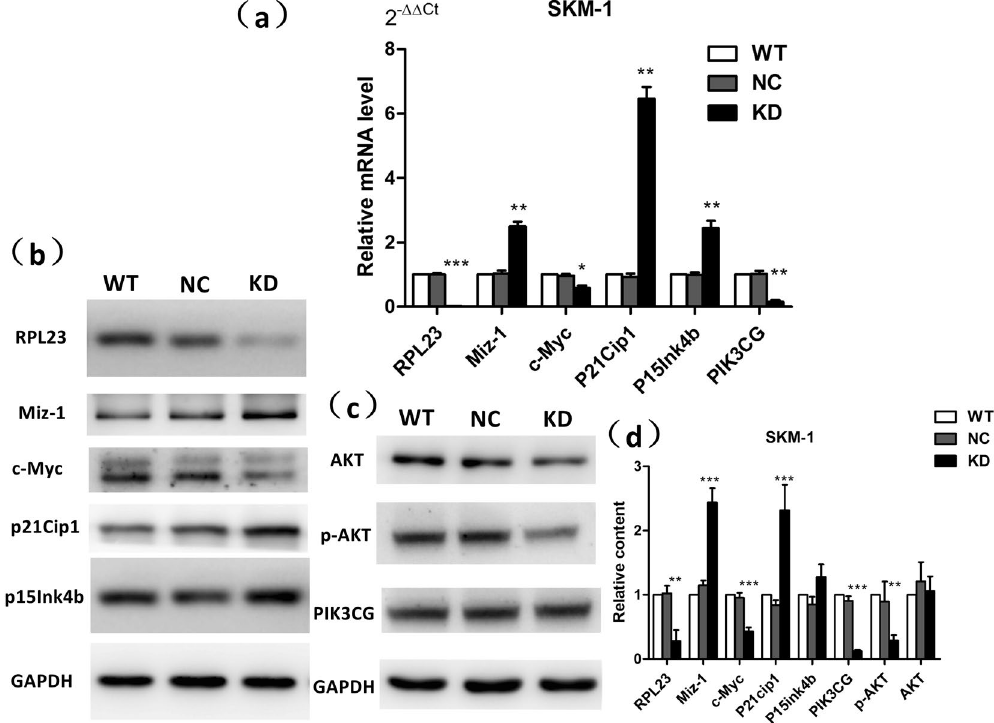
Figure 3. Validation of screened mRNAs identified by microarray analysis through qRT-PCR and western blotting of SKM-1 cells. ( a ) The mRNA expression levels of RPL23-KD-associated genes were analysed by qRT- PCR. The Miz-1 (2.50 ± 0.14, p = 0.009), p15 Ink4b (2.44 ± 0.23, p = 0.003), and p21 Cip1 (6.46 ± 0.37, p = 0.005) expression levels were increased in the KD group compared with the NC group, whereas the RPL23 (0.02 ± 0.01, p < 0.001), c-Myc (0.58 ± 0.08, p = 0.031) and PI3KCG (0.15 ± 0.05, p = 0.004) expression levels were decreased with RPL23 knockdown. ( b , c ) The western blotting results revealed altered protein levels, specifically increased expression of Miz-1 ( p < 0.001) and its downstream target molecules, p21 Cip1 ( p < 0.001) and p15 Ink4b ( p = 0.09), and decreased expression of c-Myc ( p < 0.001) and PIK3CG ( p < 0.001). The phosphorylation of AKT was also weakened ( p = 0.008). ( d ) Histogram denoting the relative grey scale of the target stripes normalized to the GAPDH expression level using Image-Pro Plus v6.0 software (Media Cybernetics, USA). Target stripes were displayed as chopped. Original scans were provided in Supplementary Information (Supplementary Fig. S5). Each assay was performed in triplicate. Unpaired Student’s t tests were used to calculate all p values shown throughout the figure. The data are expressed as the means ± S.E.M. WT: wild type; NC: RPL23-NC; KD: RPL23-KD. * p < 0.05; ** p < 0.01; *** p <